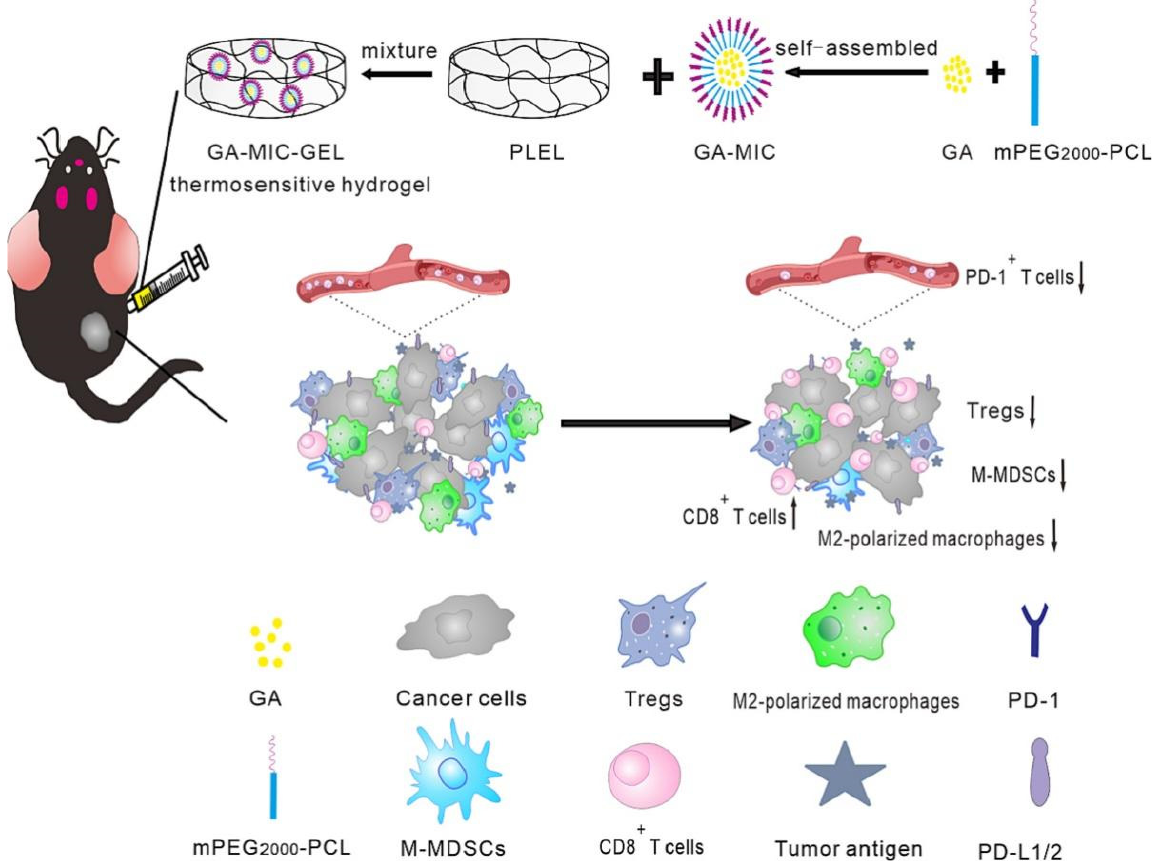
Figure 4. Schematic diagram of the in situ thermosensitive hydrogel containing GA micelles for improving anti-tumor immunity against OSCC. The GA micelle-encapsulated PLEL sol was locally injected into the tumor, formed hydrogel at body temperature, and continually released GA in situ, thus exerting the chemotherapeutic effect and anti-tumor immune activation. Reprinted with permission [128] .